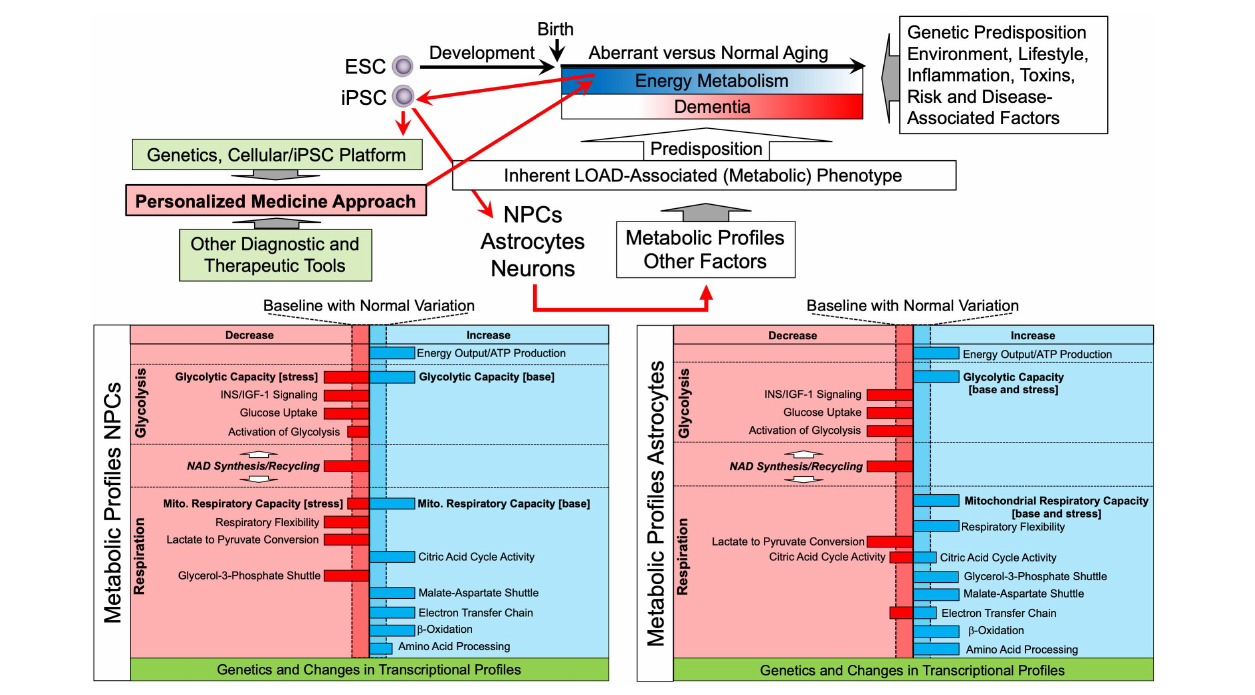
FIGURE 8 | Schematic representation of LOAD-associated metabolic profiles and a personalized medicine approach to predict and prevent altered aging and dementia. Aging is characterized by alterations and reductions of energy metabolism along with the effects of multiple other factors associated with genetic predisposition, lifestyle, environment, among others, and there are numerous risk and disease-specific factors and events. The concomitant interaction of these factors determines the aging process, i.e., normal aging without the development of major dementia, or aberrant aging that may lead to dementia, including LOAD. It is still unclear when the aging process becomes pathological and triggers disease development, but it may start occurring early in life. A personalized medicine approach using the iPSC platform in combination with genetic analysis could be applied early in life, e.g., shortly after birth, to determine individual metabolic profiles and risk factors of disease. These profiles detect and identify aberrant metabolic and other processes and factors that deviate from baseline and can be used to project one’s individual aging process and risk for neurodegenerative disease, and dementia development leading to preventive or therapeutic measures, such as lifestyle recommendations or testing personalized therapeutic interventions in the cell platform. The platform can also be combined with other diagnostic or therapeutic tools to monitor or interfere in aging or disease manifestation. ESC, embryonic stem